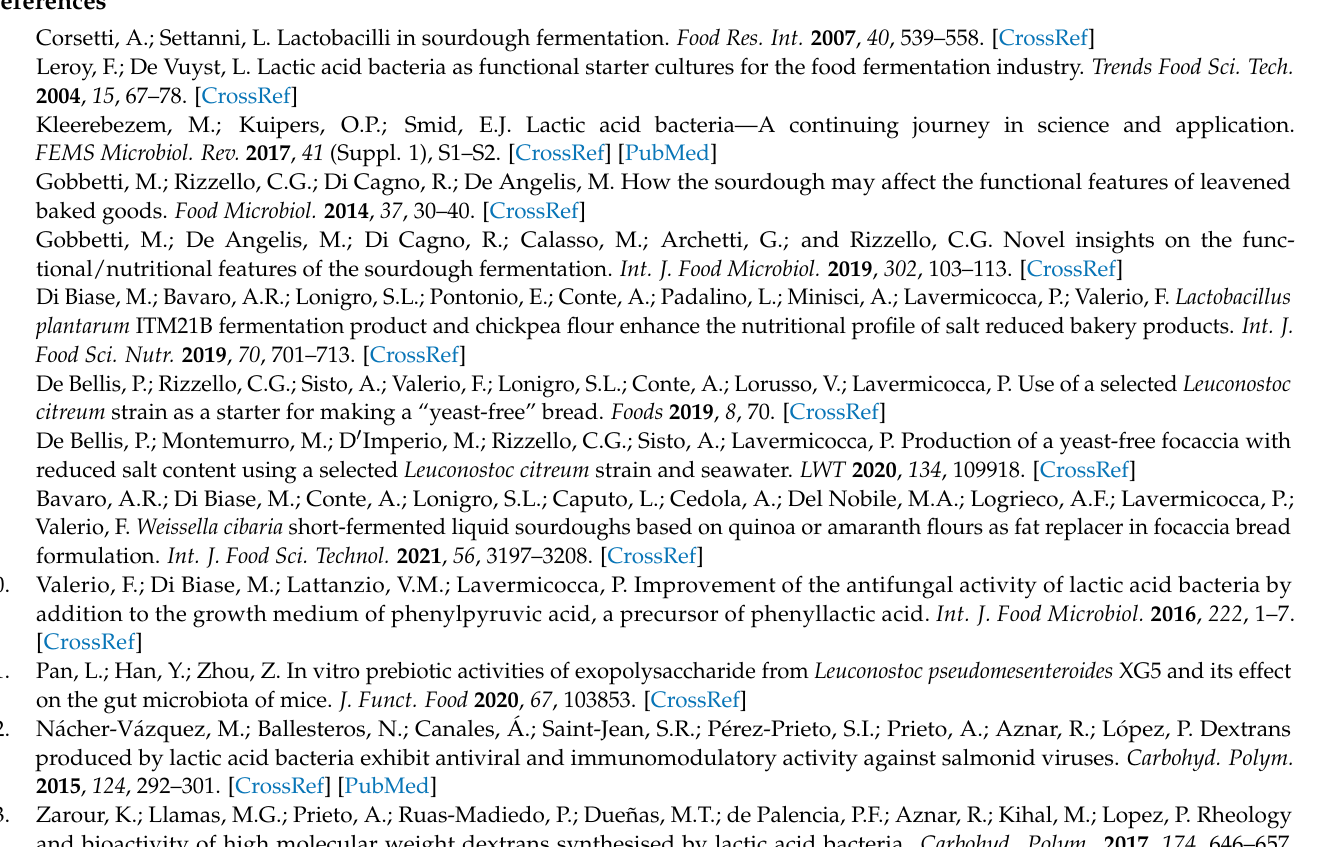
Figure S2. Typical 1D 1H NOESY NMR spectra (D2O, 400 MHz, 303 K) of free mono- (arabinose, galactose, glucose, fructose, and mannose) and disaccharides (sucrose and maltose), and purified samples from C43-11 + S and C2-32 +